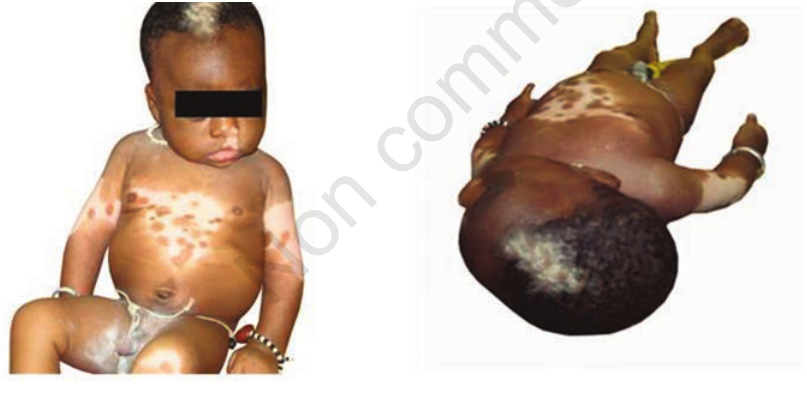
Figure 1. Clinical figures of a 2-month-old boy with congenital